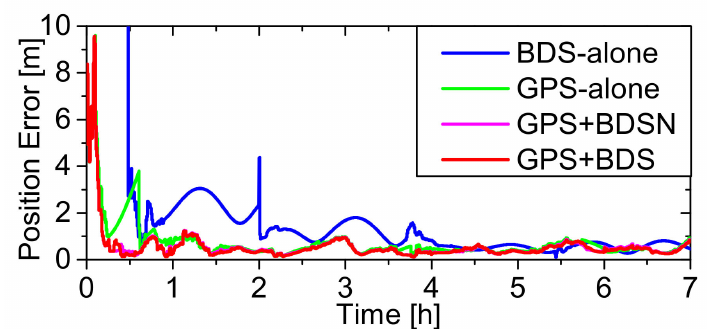
Figure 8. Position errors at the convergent stage for di ff erent GPS / BDS fusion solutions on DOY 69,